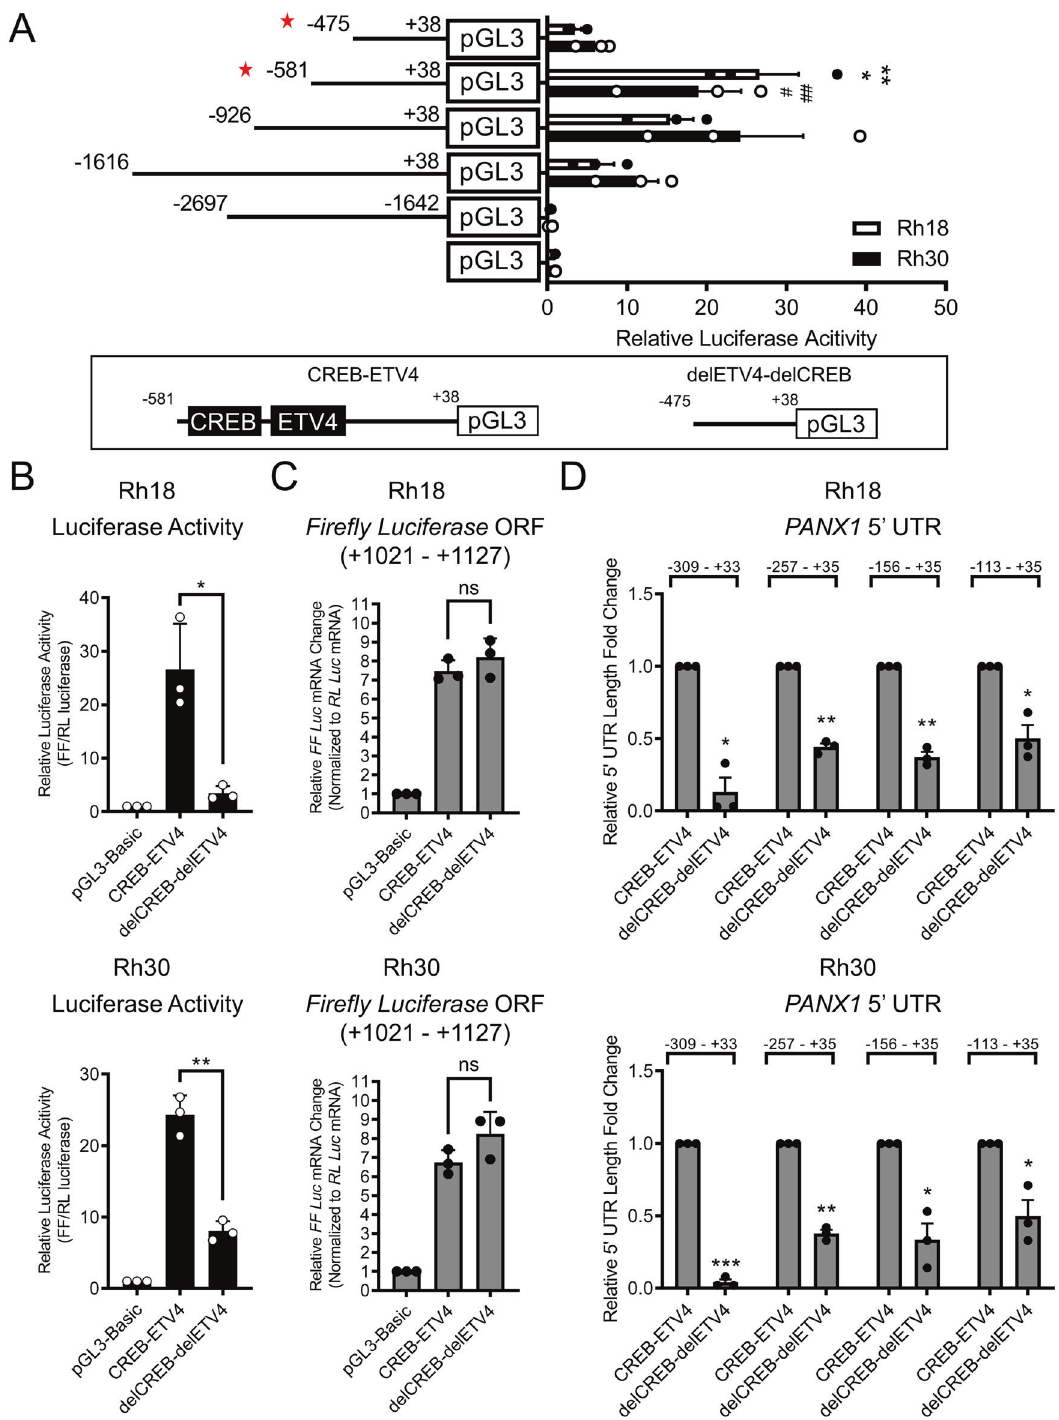
Fig. 4 A region of the PANX1 promoter containing CREB and ETV4 consensus sites regulates transcription of its 5 ′ UTR. PANX1 promoter fragment from − 2697 to − 1642 as well as promoter fragments from − 1616, − 926, − 581, and − 475 to + 38 relative to the ATG start codon were PCR ampli fi ed from primary HSMM cells and subcloned into the pGL3-basic plasmid. The pGL3 plasmids with PANX1 promoter fragments were then co-transfected with pRL-TK into Rh18 (eRMS) and Rh30 (aRMS) for 48h prior to downstream assays. A Luciferase activities from pGL3 carrying various portions of the PANX1 promoter in Rh18 ( n = 3) and Rh30 ( n = 3) cells relative to pRL-TK. Red stars highlight the two PANX1 promoter clones shown in the schematic diagrams below which were selected for further analyses. Statistical analysis was performed using one-way ANOVA with Tukey ’ s post-hoc test. *, # P <0.05 compared to − 1616 to + 38 and **, ## P <0.01 compared to − 475 to + 38. The pGL3-Basic or pGL3 carrying PANX1 promoter fragments from − 581 to + 38 (CREB-ETV4) or − 475 to + 38 (delETV4-delCREB) were co-transfected with pRL-TK into Rh18 and Rh30 cells for 48 h and subjected to dual-luciferase reporter assay ( n = 3) ( B ) and RT-qPCR analyses ( n = 3) for ( C ) Fire fl y Luciferase ( FF ) mRNA and ( D ) PANX1 5 ′ UTR levels. Statistical analysis was performed using one-way ANOVA with Tukey ’ s post-hoc test for ( B ) and ( C ), while unpaired Student ’ s t tests were used in ( D ). * P <0.05 and ** P < 0.01 in ( B ). ns indicates not signi fi cant in ( C ). Each indicated ampli fi ed region was normalized separately to CREB- ETV4 in ( D ) where * P <0.05, ** P <0.01 and *** P < 0.001 compared to their respective ETV4-CREB controls. Results are expressed as mean ±